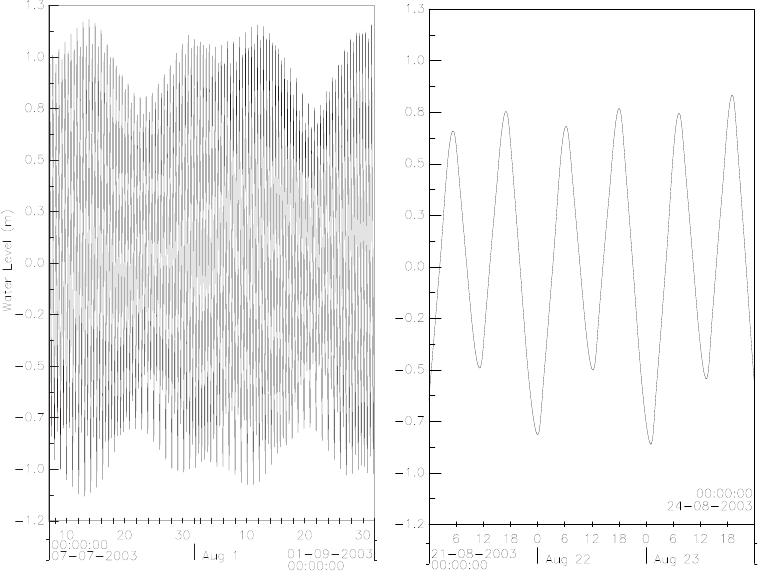
Figure 4. Time series of simulated water levels at the intake inlet locations. Left: entire 546 days; right: 3-day